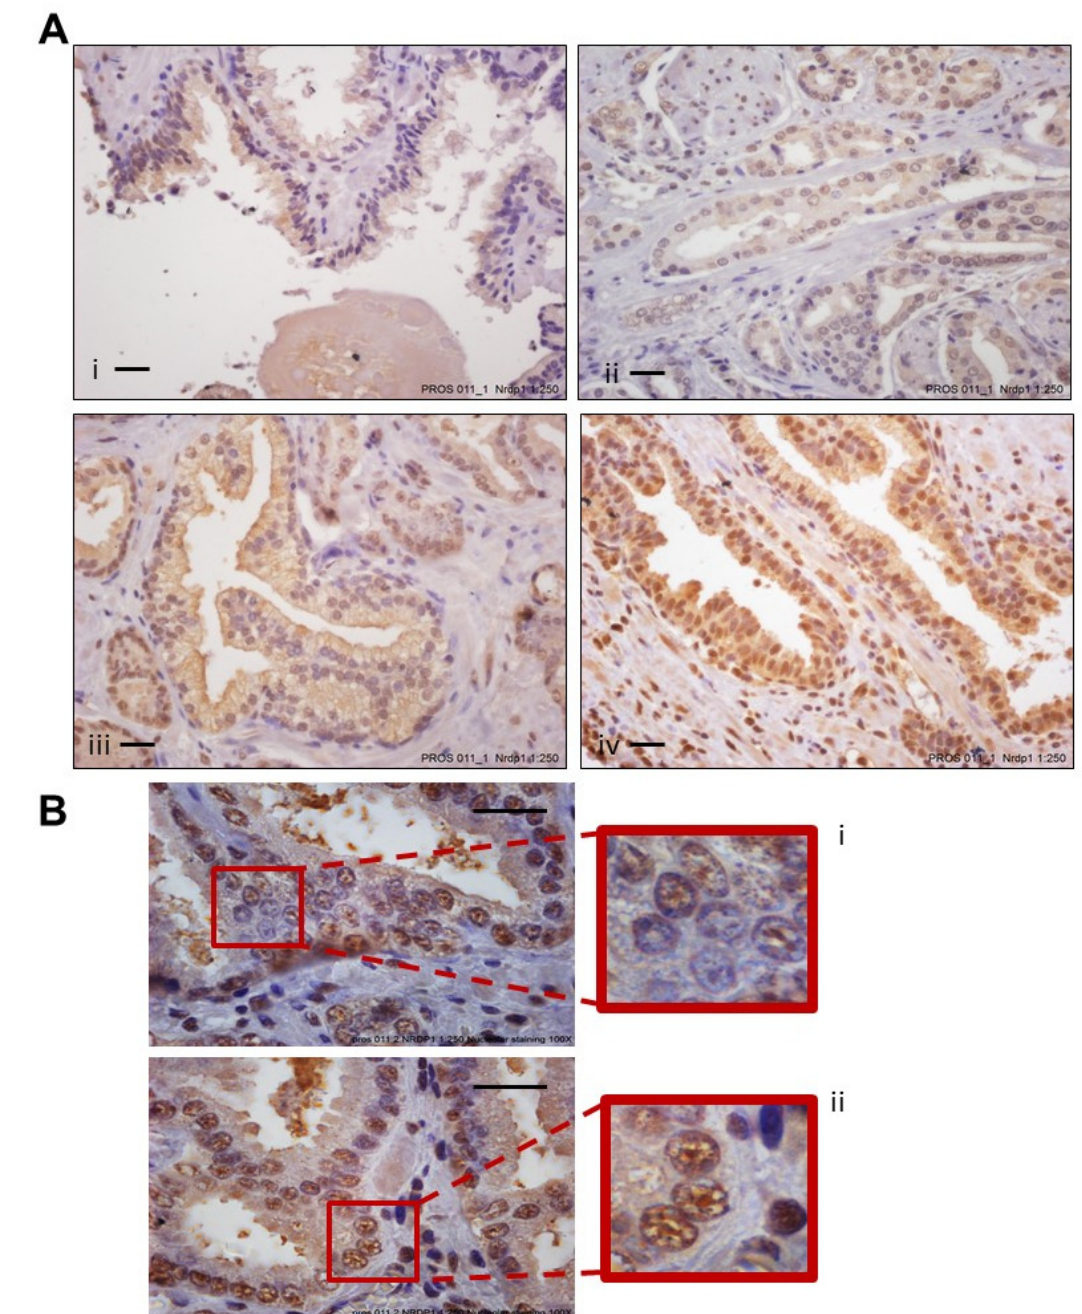
Figure 2. NRDP1 protein is also expressed in the nucleus of prostate cancer patient tumor cells. Immunohistochemical (IHC) analysis determined that NRDP1 is also located in the nucleus in prostate cancer patient cells ( A , B ). Patient samples varied in the degree of cytoplasmic:nuclear NRDP1 staining that was observed. For example, in some patients there was low cytoplasmic/low nuclear levels ( Ai ), intermediate cytoplasmic/intermediate nuclear levels ( Aii ), high cytoplasmic/low nuclear levels ( Aiii ), or high cytoplasmic/high nuclear levels ( Aiv ) of NRDP1. Higher magnification images ( Bi , Bii ) demonstrated that nuclear NRDP1 appeared as distinct puncta in the nucleus and this aligns with what was observed in prostate cancer cell lines. Scale bar = 50 µm. Brown = NRDP1, Blue = Hematoxylin (nucleus).